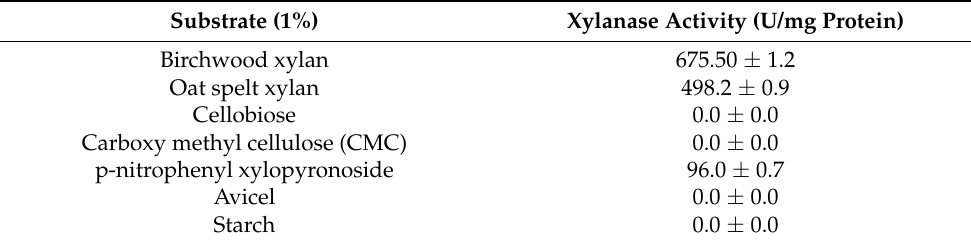
Table 3. Substrate specificity of purified